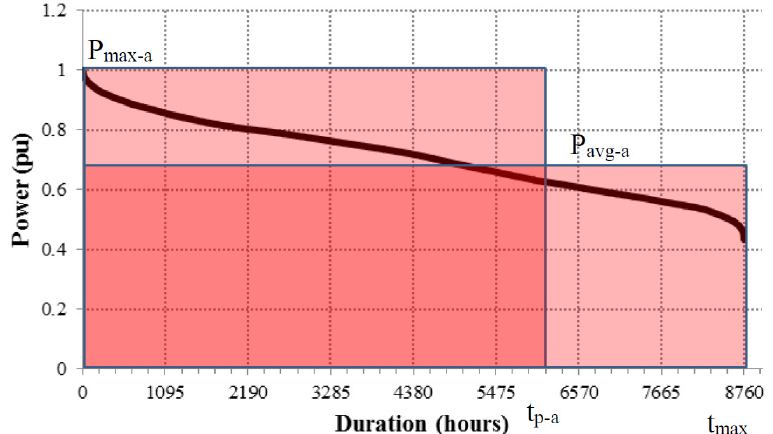
Figure 4. LDC and equivalent rectangular areas.